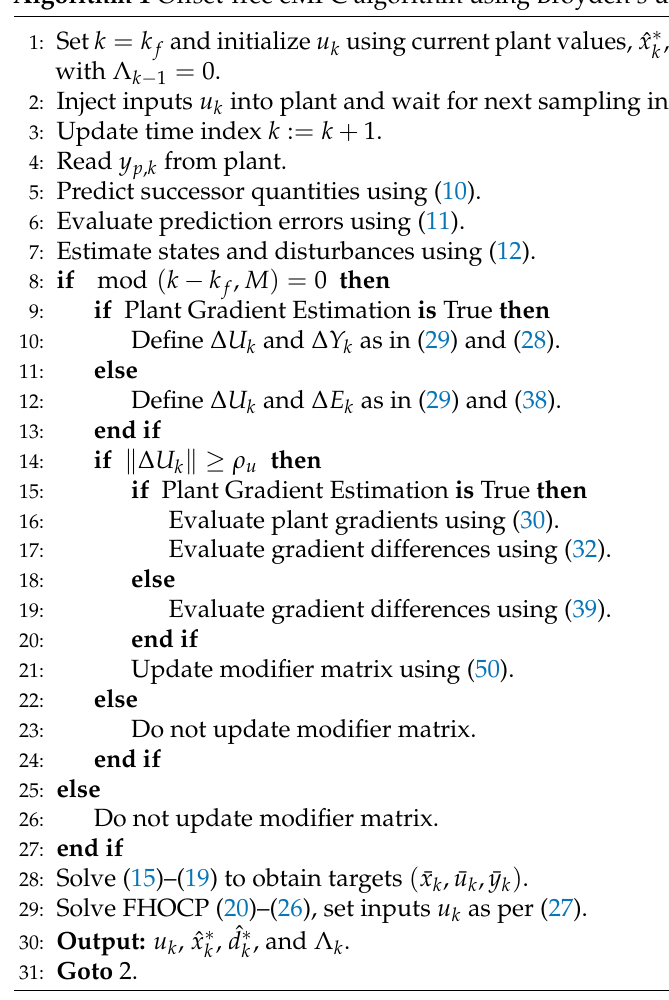
Algorithm 1 Offset-free eMPC algorithm using Broyden’s